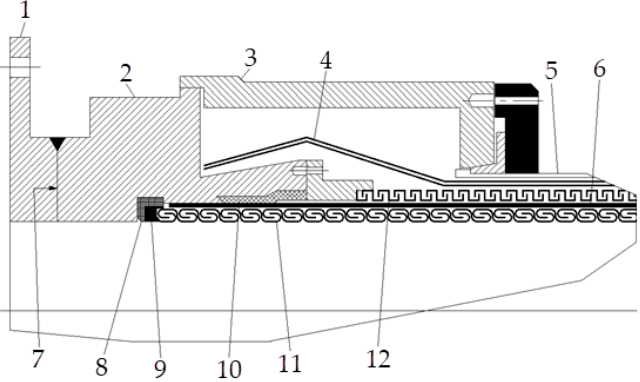
Figure 1. Typical structure of a flexible pipe end fitting. 1: mounting flange; 2: inner casing; 3: outer casing; 4: tensile armor layer; 5: outer sheath; 6: inner sheath; 7: end fitting neck; 8: insulator; 9: carcass end ring; 10: sealing ring; 11: carcass; 12: pressure armor layer.